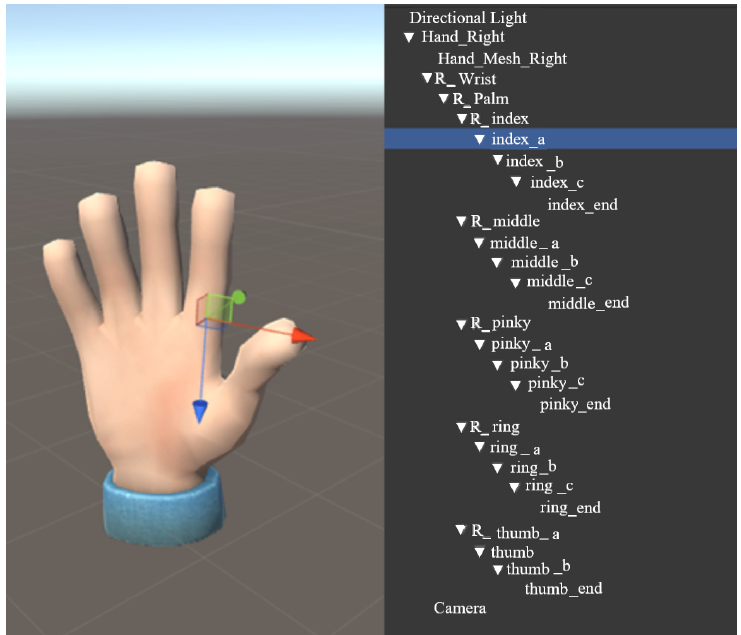
Figure 10. Virtual hand model.